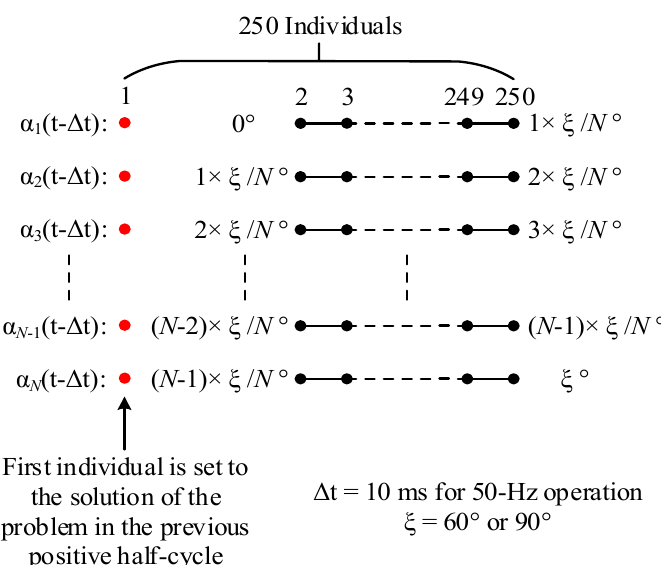
Figure 11. Generalized lattice structure used for population initialization in each positive half-cycle of line ‐ to ‐ neutral voltage.